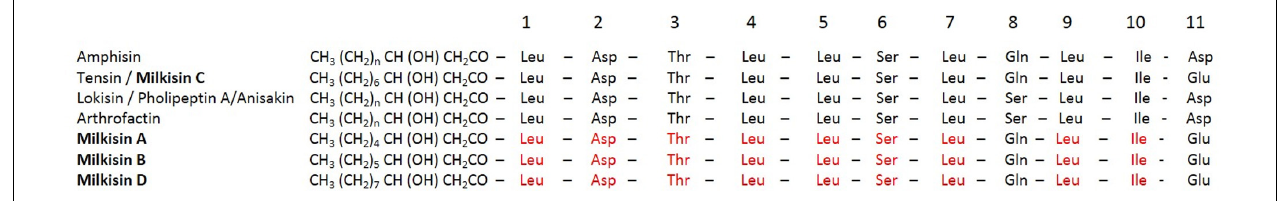
Frontiers in Microbiology |